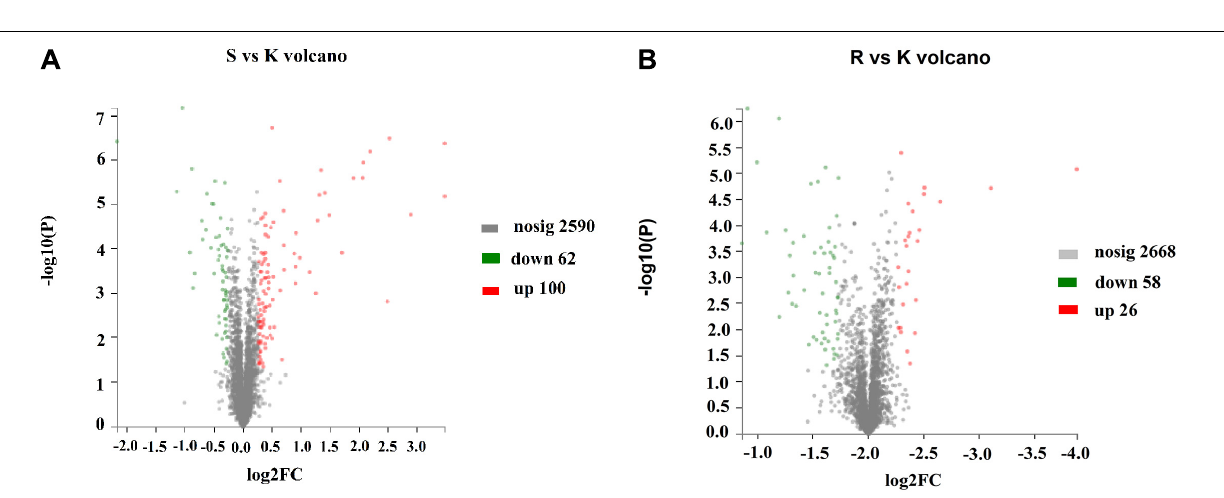
Frontiers in Microbiology |